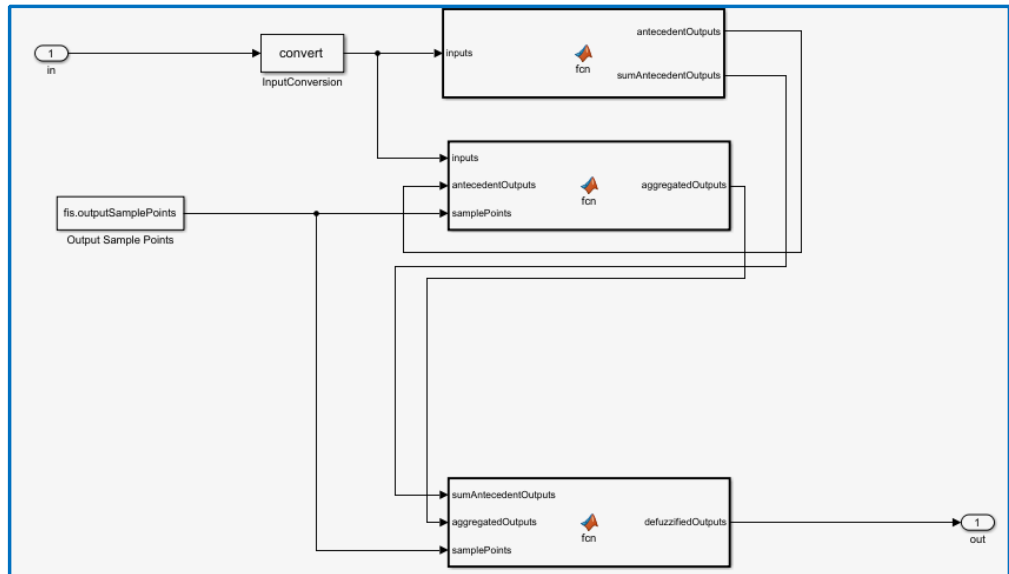
Figure 6. Simulink model of D-STATCOM controller.